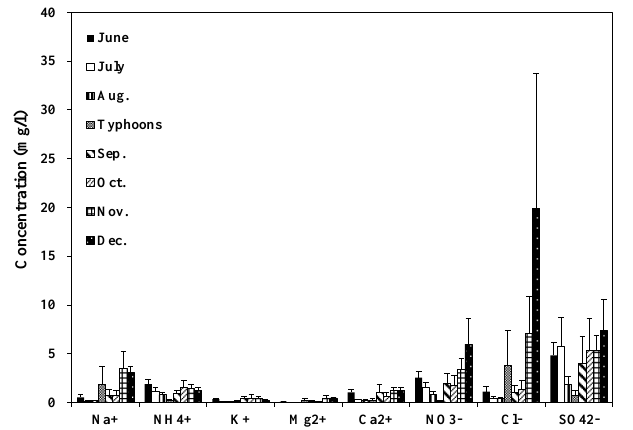
Figure 5. Monthly variation of VWMC of major ions in rainwater samples during 2012.